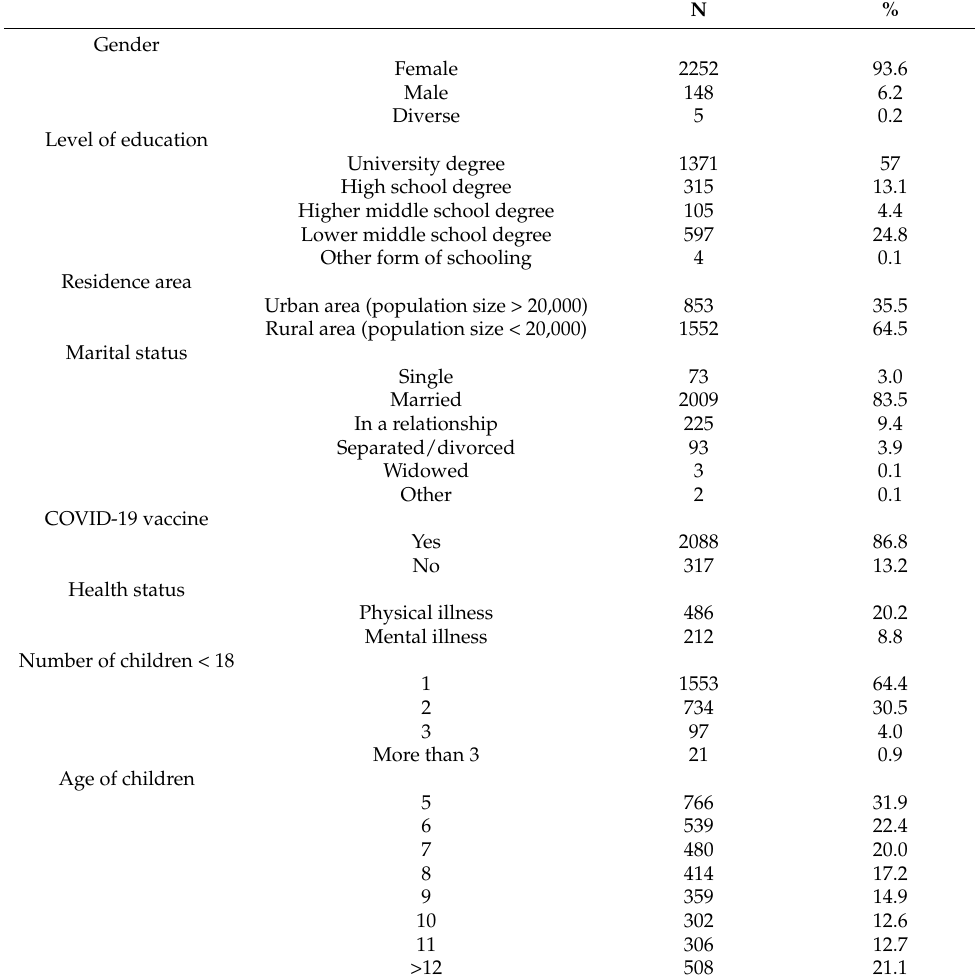
Table 1. Demographic Characteristics of the Sample (N =